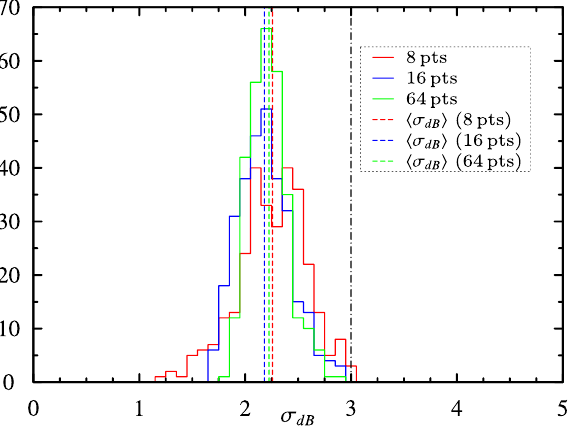
Figure 5: Histograms of values of σ dB obtained for 8 (red), 16 (blue), 64 (green) measurement points in the chaotic RC. The red, blue and green dashes represent respectively the average value of σ dB for 8, 16 and 64 points. The limit at 3 dB is also shown. The percentages of values above this limit are respectively: 0.33 % , 0 % and 0 % .